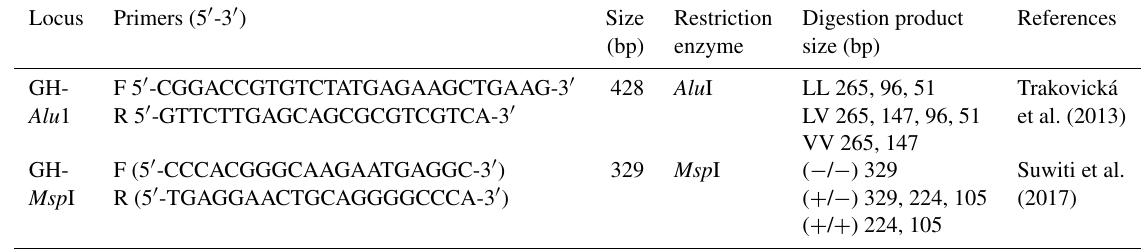
Table 1. Primer sequences, sizes of the amplified fragments in PCR and sizes of the observed genotypes. Locus Primers (5 (cid:48) -3 (cid:48) )